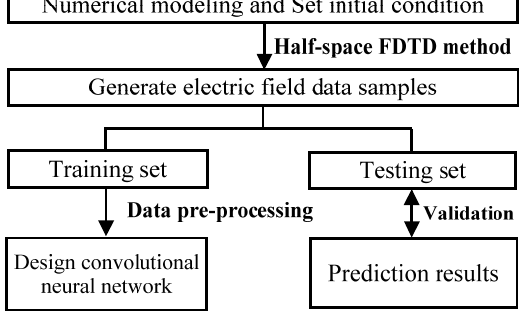
Figure 3. Overall framework of the proposed CNN model.